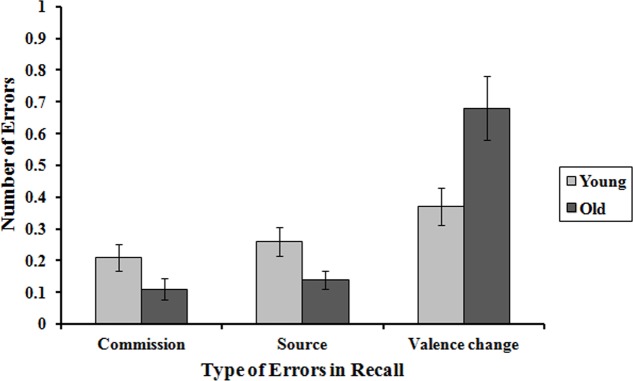
Mean number of errors in the recall of future events in young and old adults. Error bars represent standard errors.